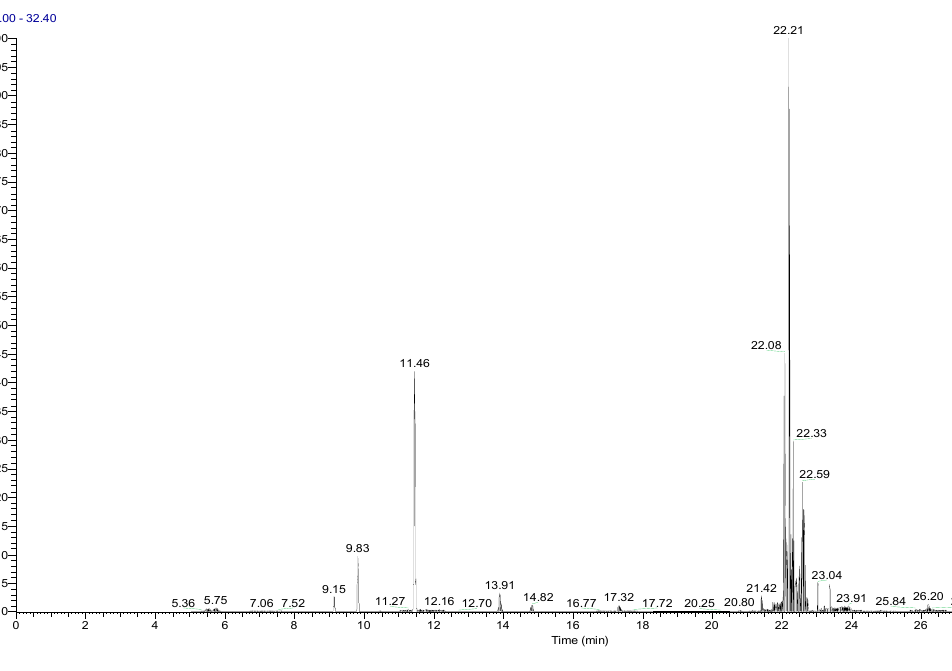
Figure 2. Total ion chromatogram (TIC) of 77 pesticides in red ginseng.